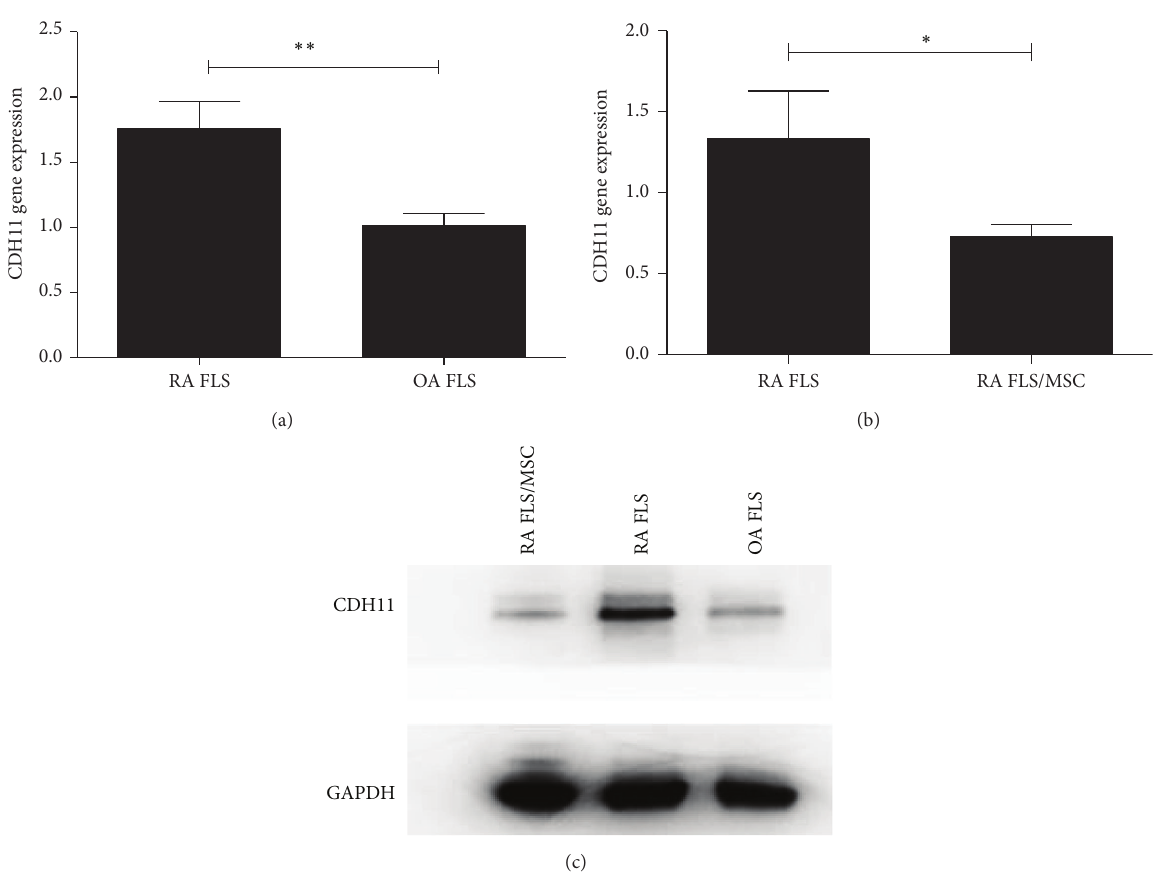
Figure 2: Effects of UCMSC on CDH11 expression by FLS from RA patients (a)–(c). Expression of CDH11 mRNA (a) and protein (c) by FLS from RA patients. RA: rheumatoid arthritis; OA: osteoarthritis; MSC: mesenchymal stem cells; CDH11: cadherin-11. ∗ 𝑃 < 0.05 ; ∗∗ 𝑃 < 0.01 (b)-(c). Expression of CDH11 mRNA (b) and protein (c) by FLS from RA patients, cocultured with UCMSC. RA: rheumatoid arthritis; OA: osteoarthritis; MSC: mesenchymal stem cells; CDH11: cadherin-11. ∗ 𝑃 < 0.05 ; ∗∗ 𝑃 < 0.01